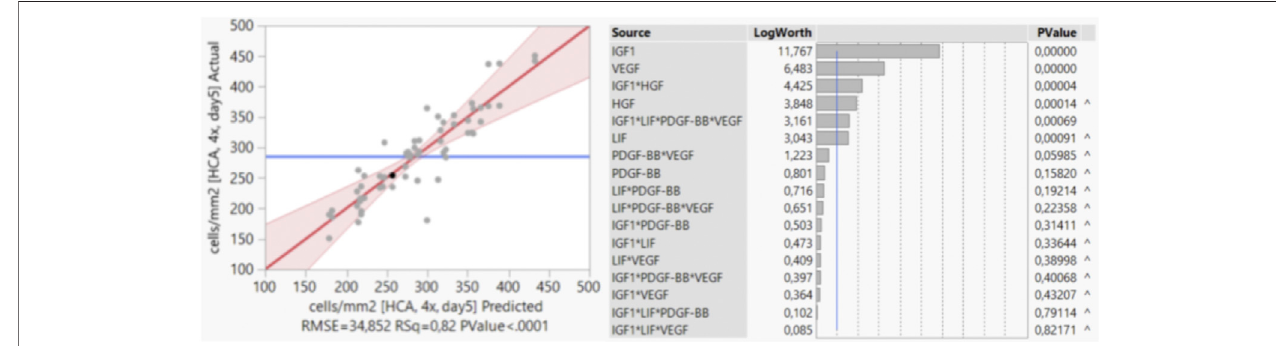
FIGURE3 | Stepwise regression analysis in JMP ® . Scatter plot showing theactual values and the values predicted bythe model. Effect summary ofall factorsand factor combinations that were selected by the model, ranked based on their respective p -values.